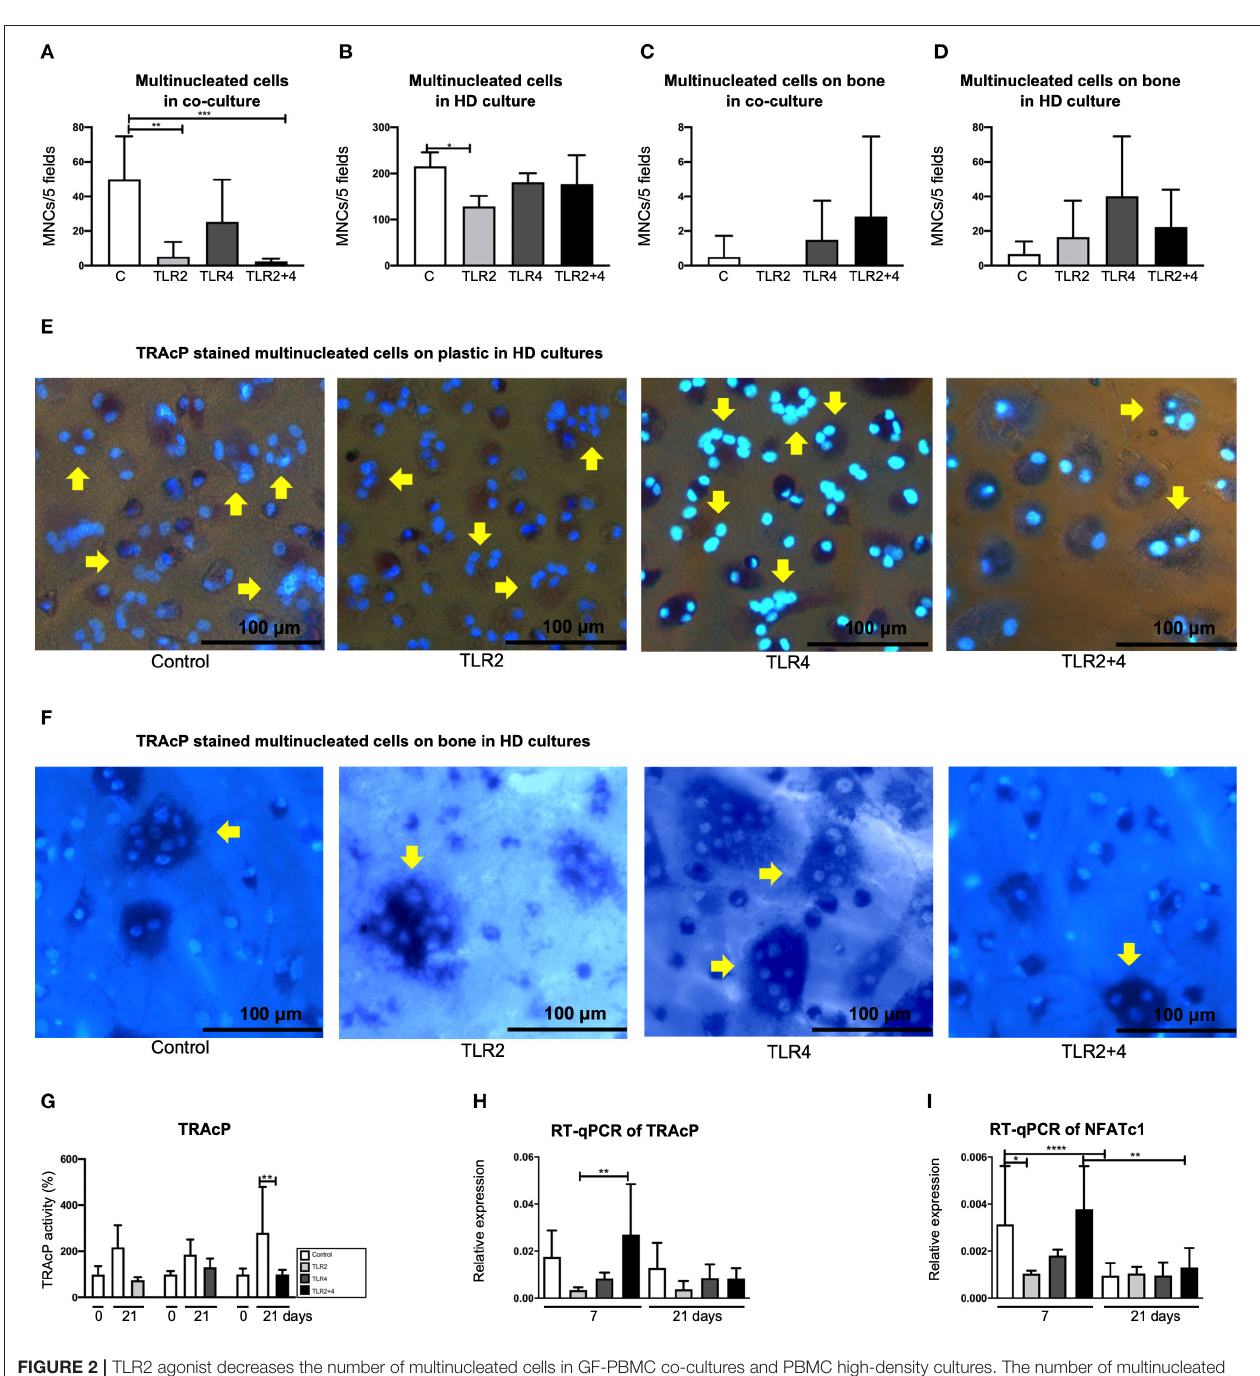
Frontiers in Immunology |